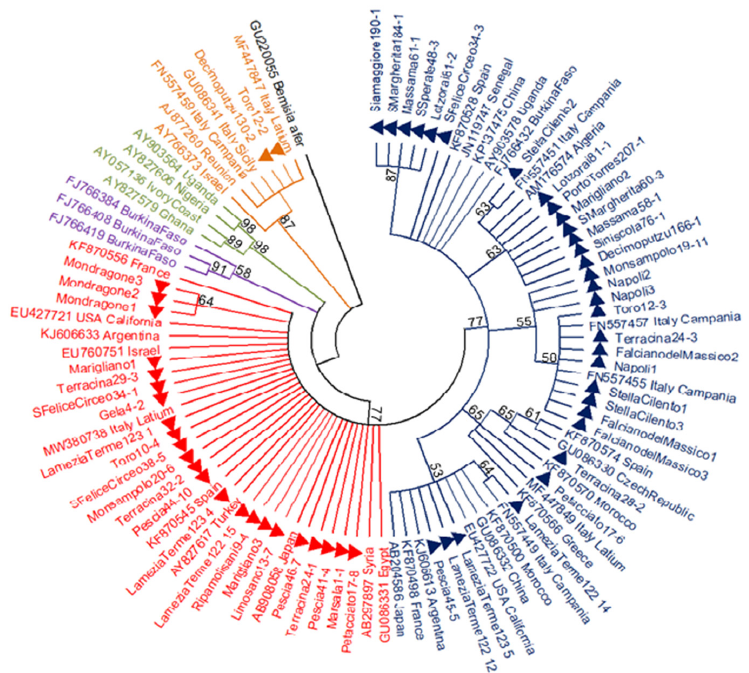
Figure 2. Maximum-likelihood (ML) majority rule tree obtained using 866-bp mtCOI sequences of 56 Bemisia tabaci specimens collected in this study (filled triangles) and those sourced from GenBank, for a total of 92 sequences. A COI sequence of Bemisia afer was used as the outgroup. The consensus tree was obtained after 1000 bootstrap replicates; branches with <50% bootstrap values are collapsed. Colours represent the different species and haplogroups of B. tabaci : MEAM1, orange; MEDQ1, dark blue; MEDQ2, red; MEDQ3, purple; MEDASL, green.